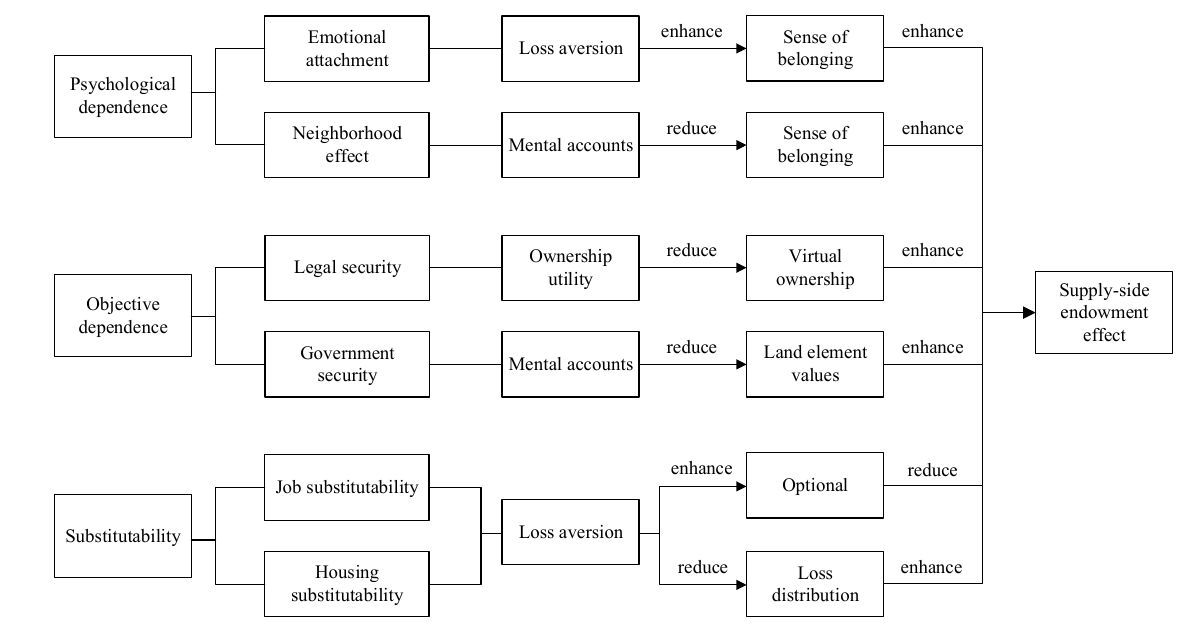
Figure 1. Influencing factors of supply-side endowment effect.